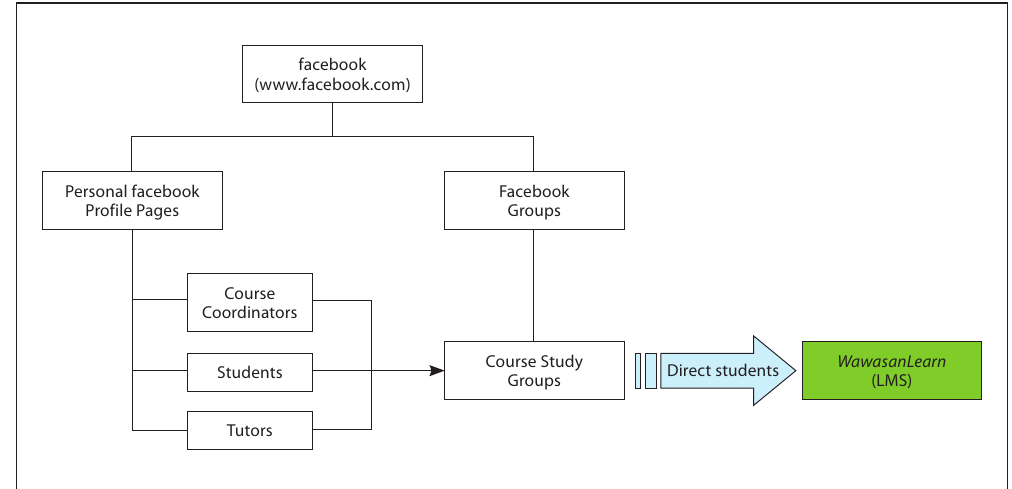
Figure 4 Structure of the Facebook study